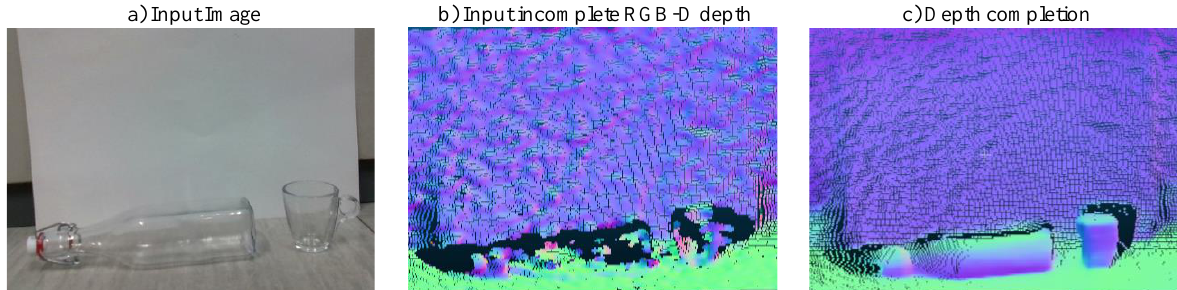
Figure 5. Depth completion using a learning-based method (Sajjan et al., 2020): a depth map of a scene with two transparent objects (glass bottle and tea cup) placed at the scene. Given an RGB input image (a) with an uncompleted depth map (b), the missing areas from input depth were predicted (c).